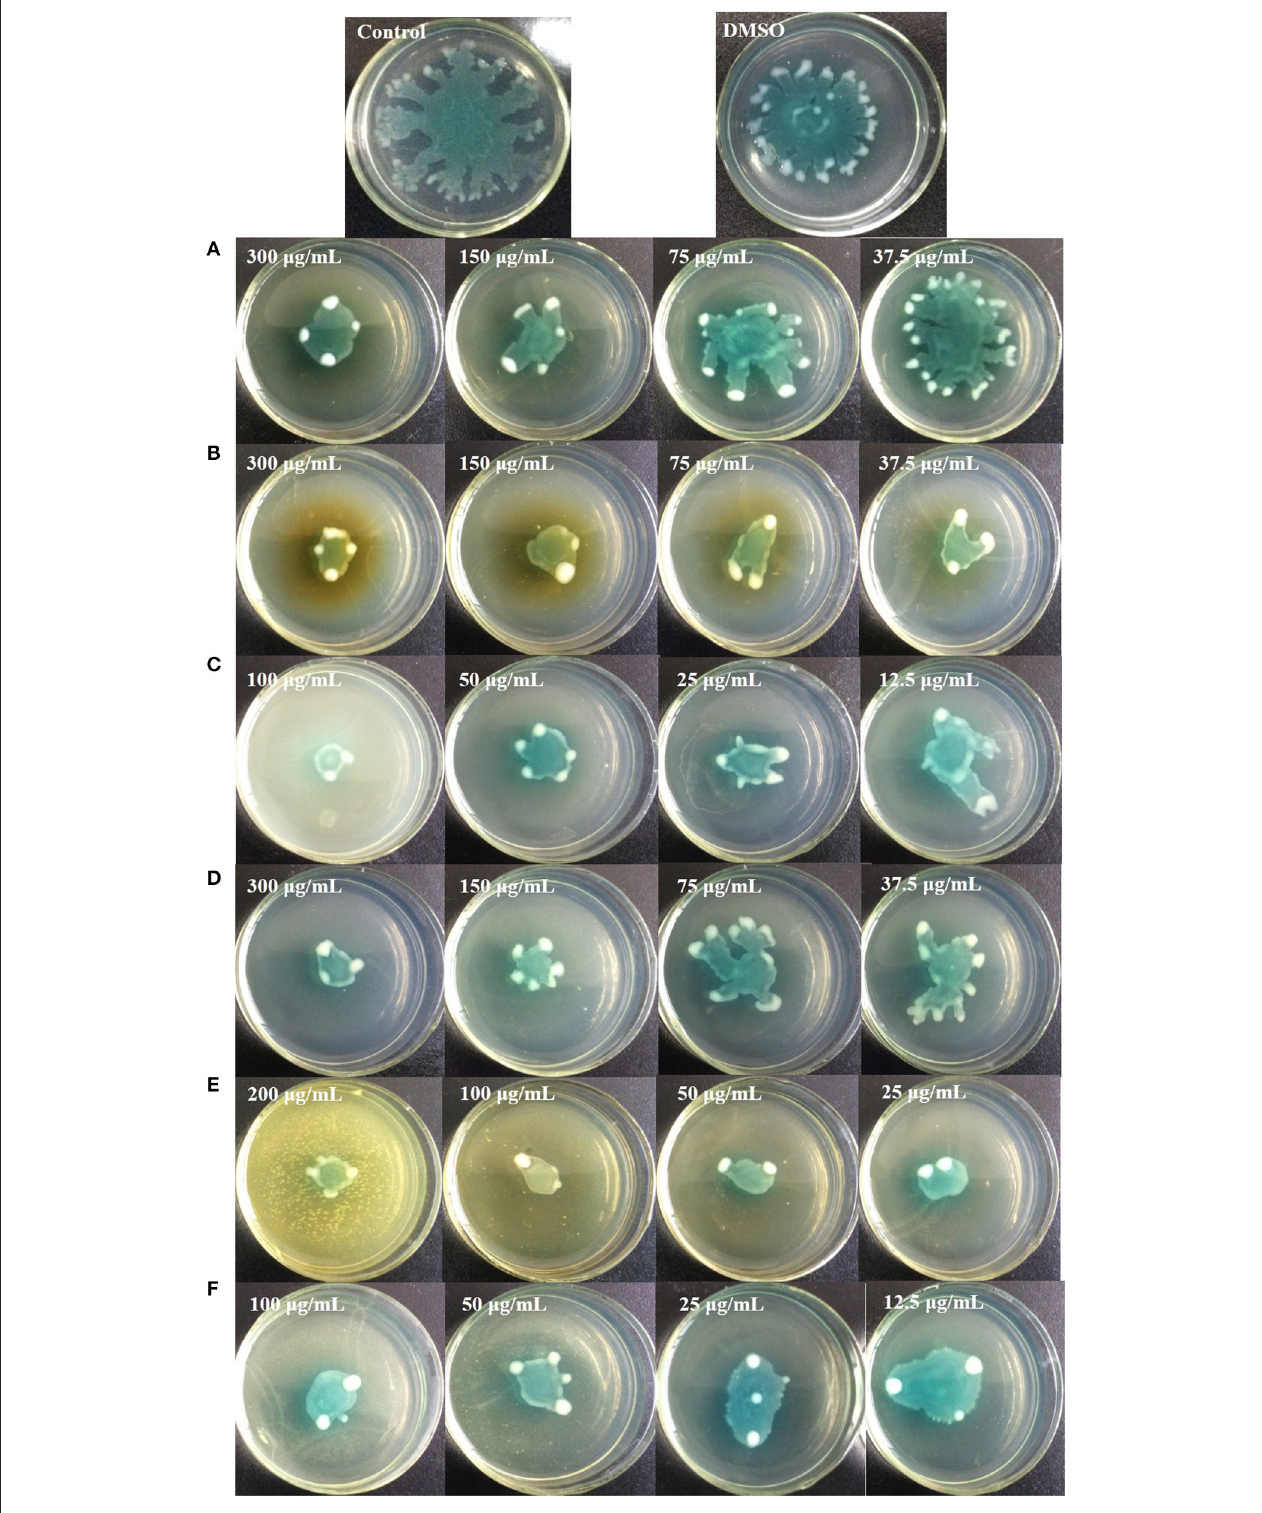
FIGURE 9 | Swarming inhibition assays of the six identified compounds. Gallic acid (A) , Catechin (B) , Ellagic acid (C) , Chlorogenic acid (D) , Quercetin (E) , and Kaempferol (F) .